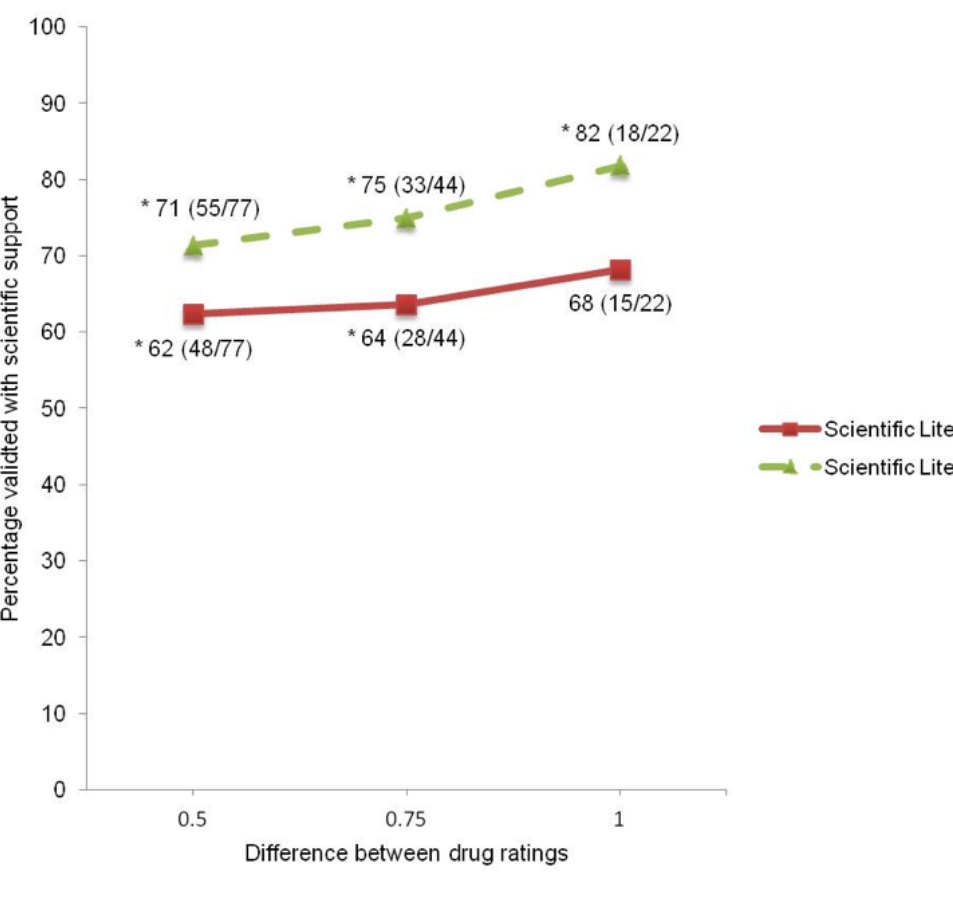
Figure 2. Concordance between deduced online trends and scientific support at varying levels of point differences between 2 drugs’ online ratings. The solid line indicates the concordance of online trends with literature and the dashed line indicates the concordance of online trends with scientific literature and FDA labels. For each data point, the percentage concordance is shown and the number of drug pairwise comparisons agreeing with scientific support divided by the total number of drug pairwise comparisons are given in parenthesis. The asterisk indicates statistical significance with P<.05 according to the binomial test.